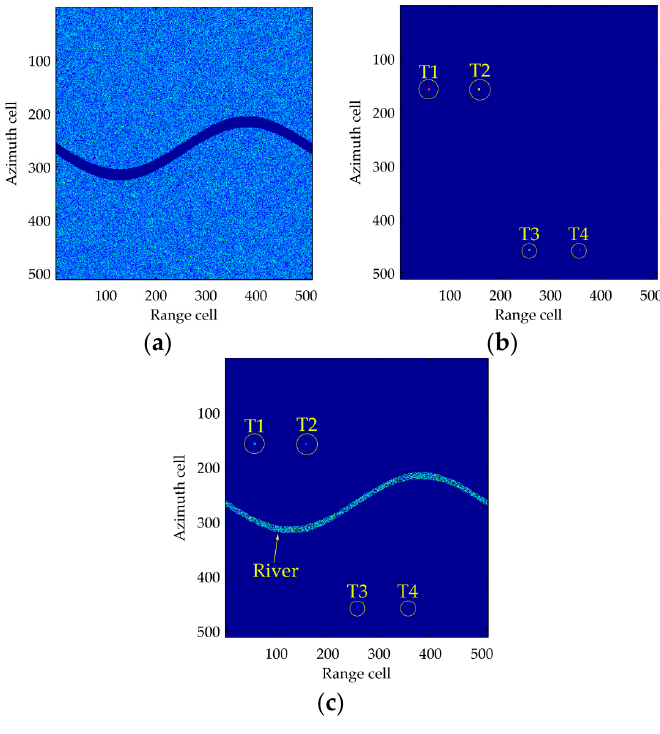
Figure 5. The results of the proposed RR-DPCA method based on simulated data. ( a ) 1th channel SAR image; ( b ) CFAR result of DPCA; ( c ) CFAR result of RR-DPCA.